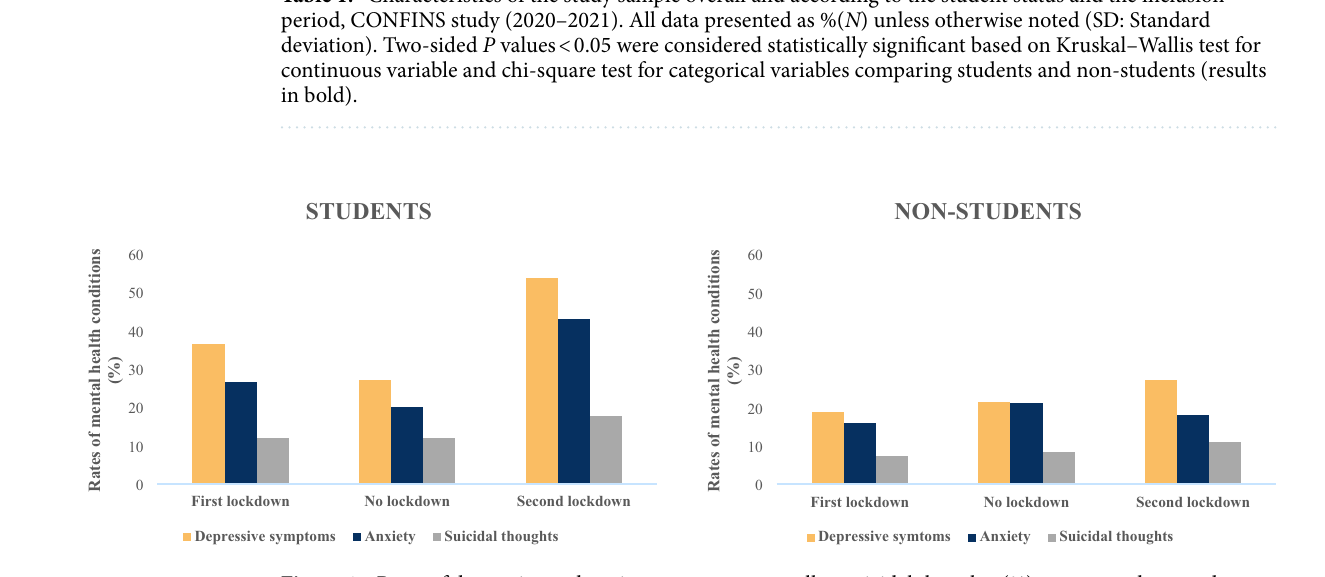
Figure 1. Rates of depressive and anxious symptoms as well as suicidal thoughts (%) among students and non- students according to key periods of the COVID-19 epidemic in France, CONFINS study depressive symptoms during the first lockdown was nearly twice as high in students as in non-students (36.3% vs. 18.7%; P < 0.0001). In period 2 with no lockdown restrictions, the difference was attenuated (27.1% in stu- dents vs. 21.4%; P = 0.0677) and non-significantly different. However, during the second lockdown, more than one-half of the students had depressive symptoms, compared with about one-quarter of the non-students (53.6% vs. 27.1%; P < 0.0001). Multivariate analyses confirmed significant variations in the rates of mental health conditions over time in the student population, but not in the non-student population (Table 2). Adjusting for age, gender, psychiatric